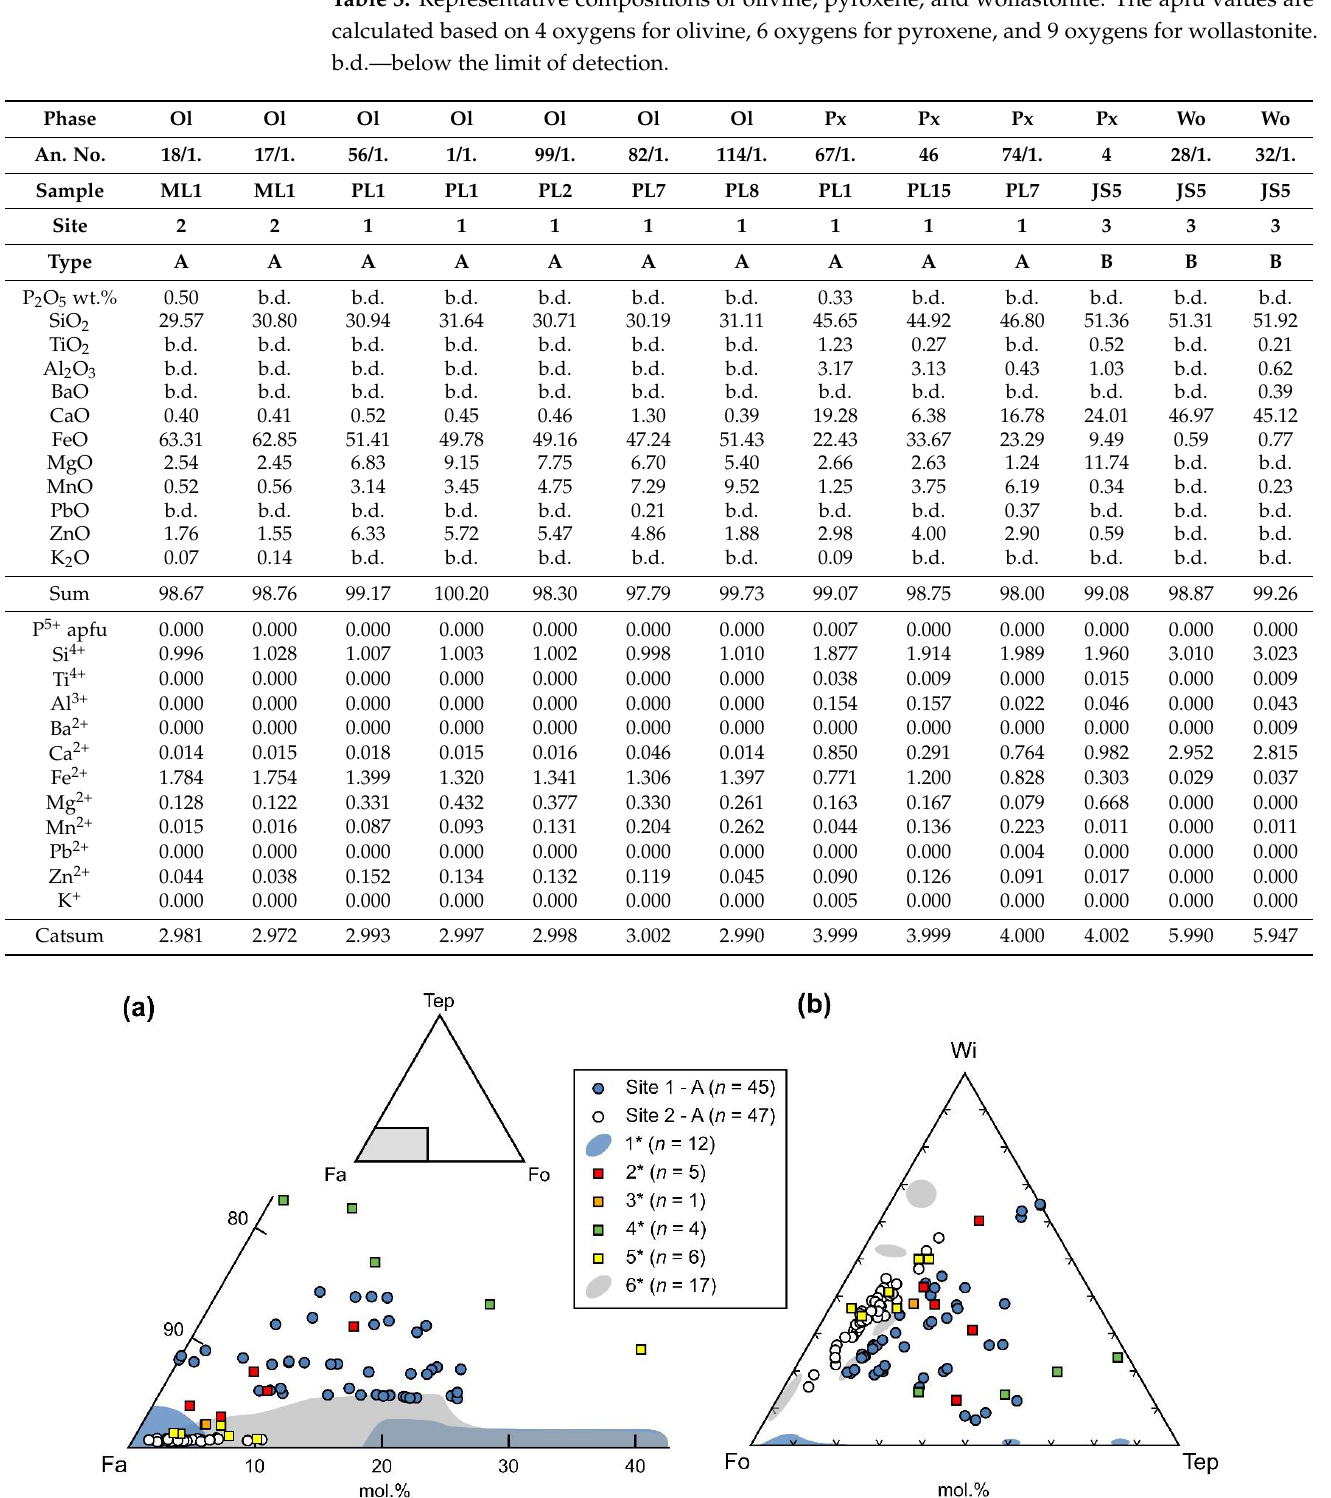
Figure 5. Composition of olivine projected into the Tep-Fa-Fo ( a ) and Wi-Fo-Tep ternary plots ( b ). Comparative data: 1* — Lower Silesia (Poland; [10]), 2* —Příbram (Czech Republic; [44]), 3*— Kutná Comparative data: 1*—Lower Silesia (Poland; [10]), 2*—Pˇr í bram (Czech Republic; [44]), 3*—Kutn á Hora (Czech Republic; [6]), 4* —Příbram (Czech Republic; [8]), 5*— Capattoli Valley (Italy; [4]), 6* — Hora (Czech Republic; [6]), 4*—Pˇr í bram (Czech Republic; [8]), 5*—Capattoli Valley (Italy; Wiesloch (Germany; [9]).